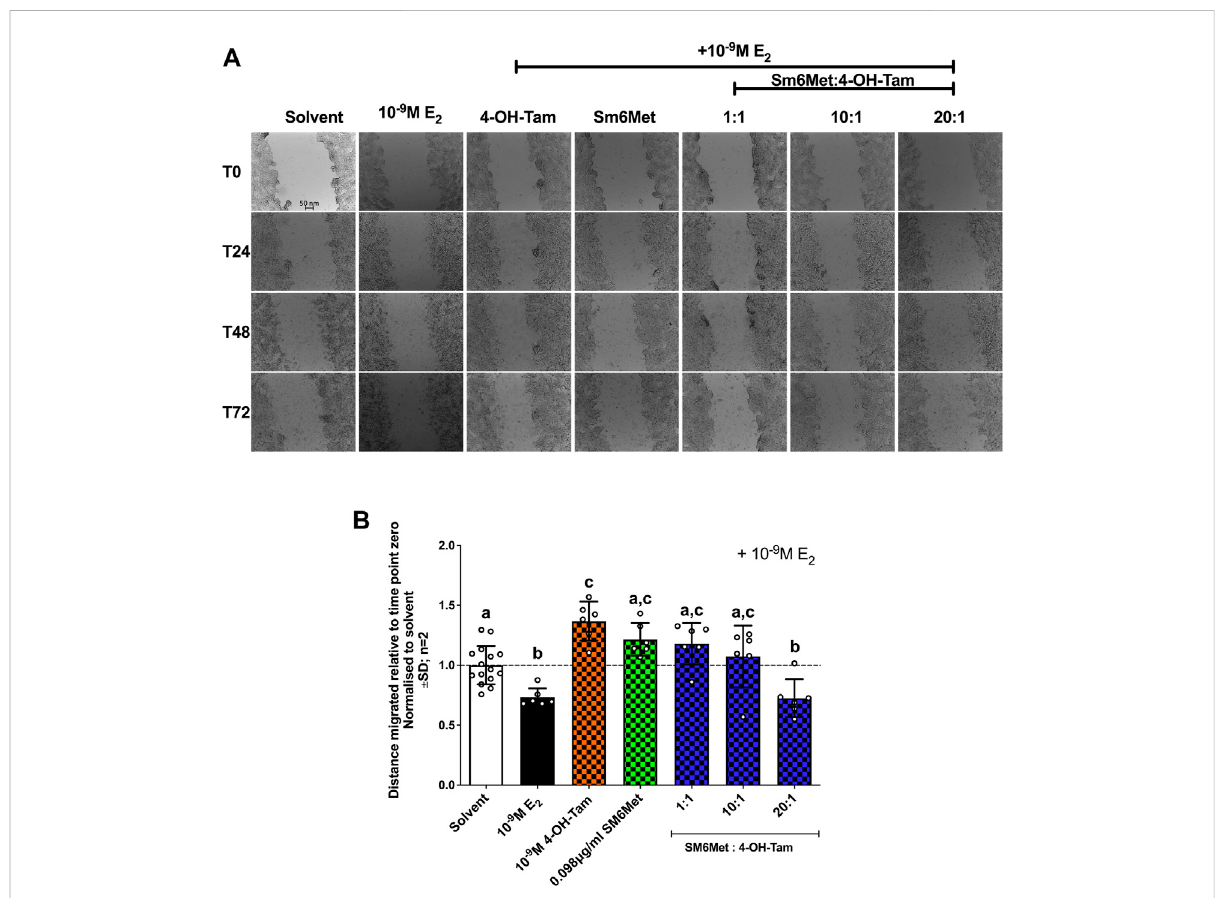
FIGURE 4 Increasing the concentration of SM6Met in the combinatorial ratio with 4-OH-Tam reduced breast cancer cell migration. (A) Directly after treatment, time point zero (T 0 ), the scratch wounds were captured using an Olympus IX81 wide fi eld microscope at 10x magni fi cation in 24 h intervals, starting at T 0 and ending after 72hrs (T 72 ). (B) The distance migrated was calculated using the formula T 72 -T 0 /T 0 for each compound or extract and normalised to solvent. The dotted line through the bars represents the solvent, which was set to one. Average ± SD is of two independent biological experiments done in triplicate. Statistical analysis was performed using one-way ANOVA with Tukey ’ s multiple comparisons test as post-test, where different letters indicate statistically signi fi cant differences at p < 0.05. Bars with common letters are not signi fi cantly